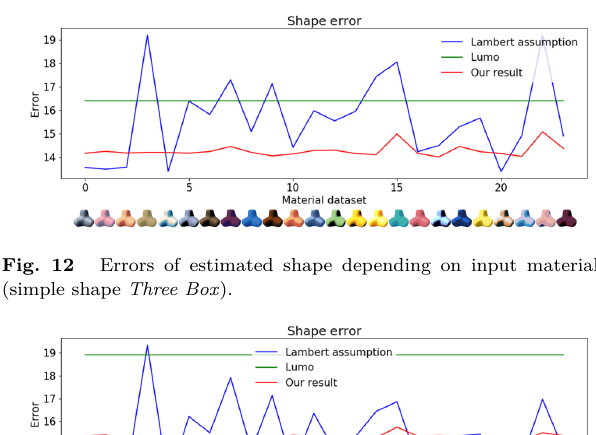
Fig. 11 Shading analysis results for different color map materials.